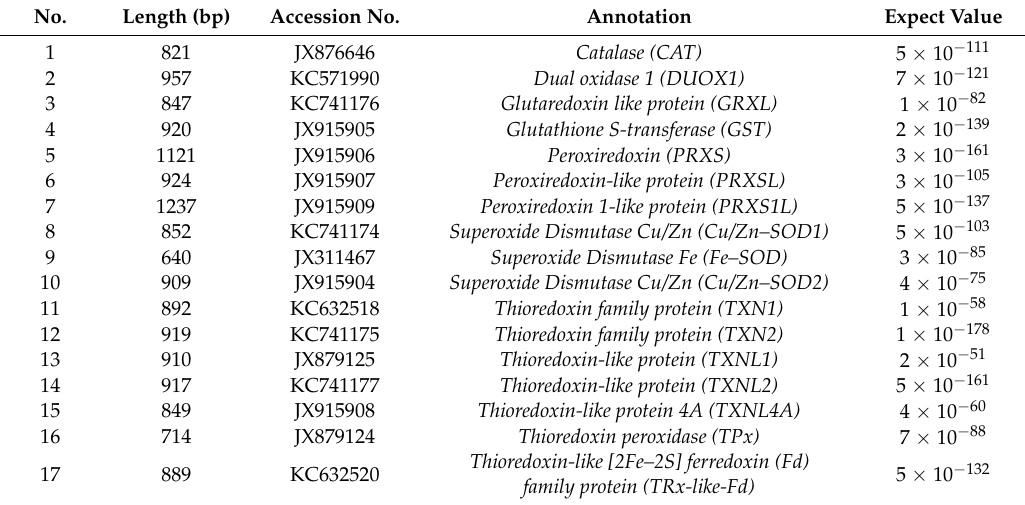
Table 2. Identified antioxidant defense-related genes of C. formosanus Shiraki based on sequence similarity (E ≤ 10 − 5